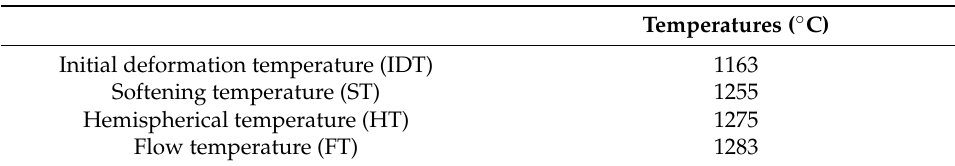
Table 3. C. striatus ash fusibility temperatures.